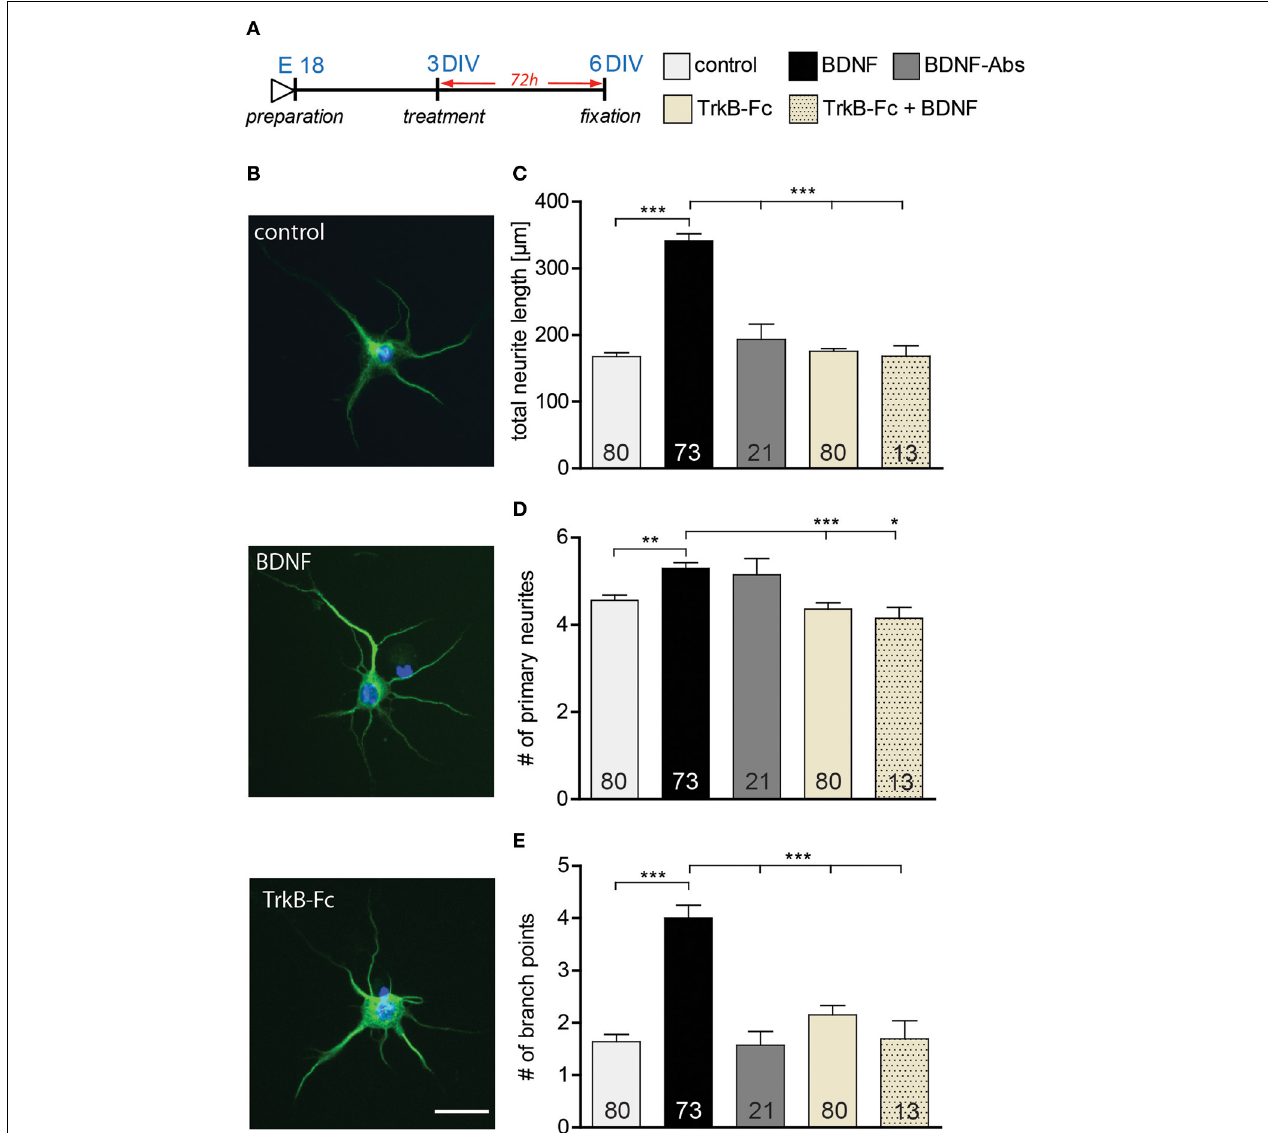
FIGURE 5 | (A) Experimental timeline. BSA, BDNF, BDNF antibodies (BDNF-Abs) or TrkB receptor bodies (TrkB-Fc) were applied on DIV3 hippocampal neurons for 72h. (B) Micrographs showing MAP2 positive BSA (control) (above), BDNF (middle) or BDNF antibodies (BDNF-Abs; below) treated primary hippocampal neurons. Scale bar, 25 μ m. (C) Histogram comparing neurite length of DIV6 hippocampal neurons after application of BSA (control), BDNF, BDNF antibodies (BDNF-Abs), TrkB receptor bodies (TrkB-Fc) or combined BDNF and TrkB receptor bodies (TrkB-Fc). (D) Histogram comparing the number of primary neurites of DIV6 hippocampal